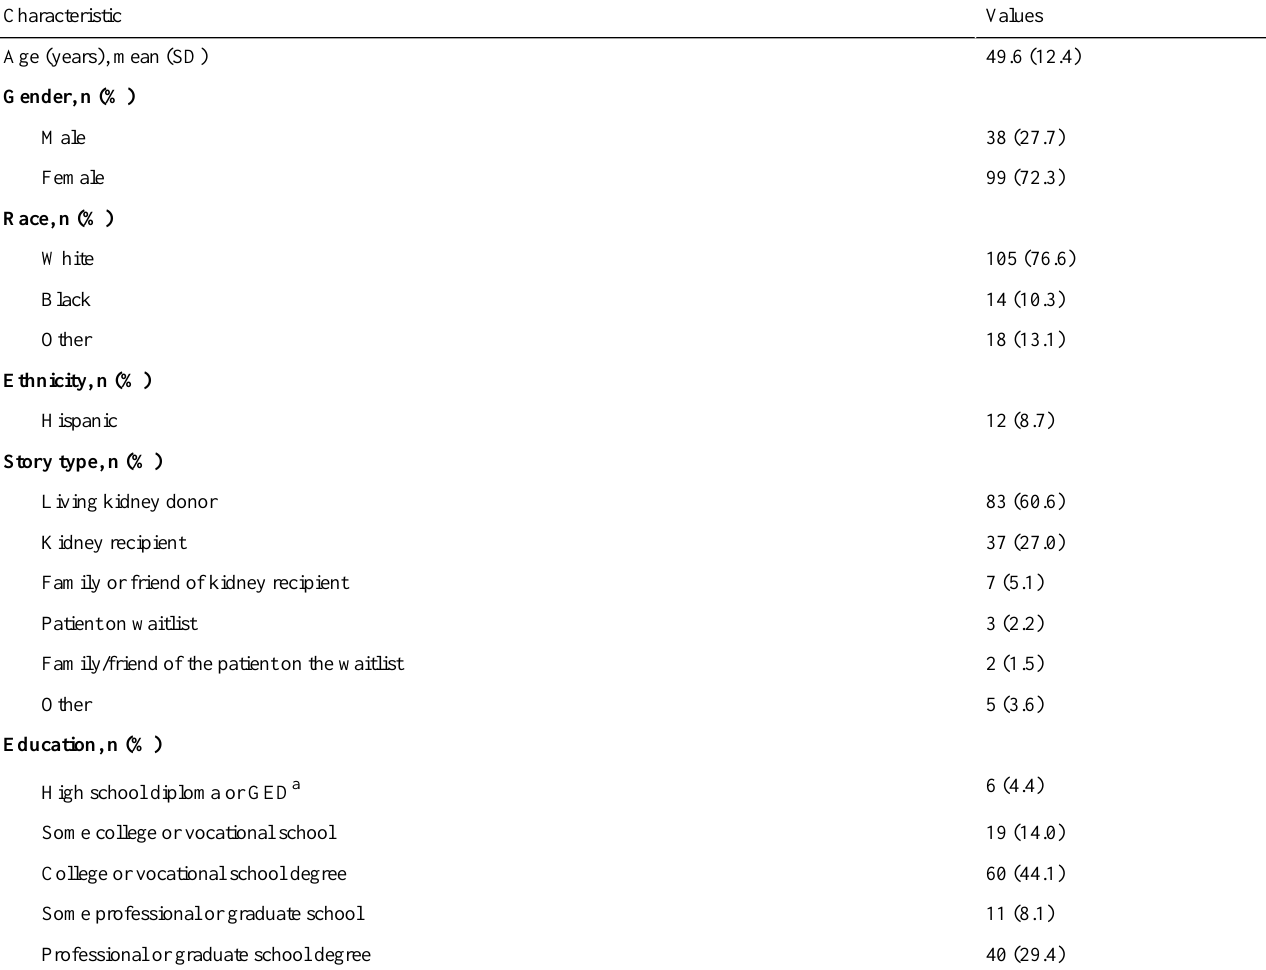
Table 1. Storyteller characteristics